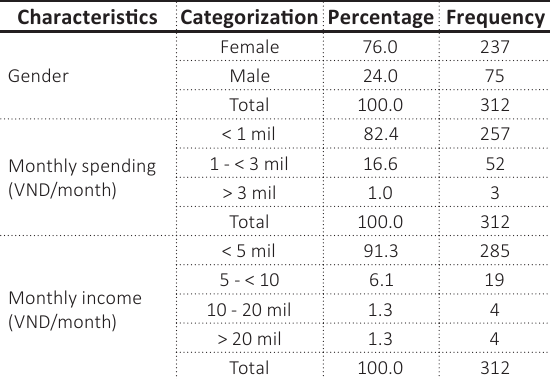
Table 2. Sample characteristics